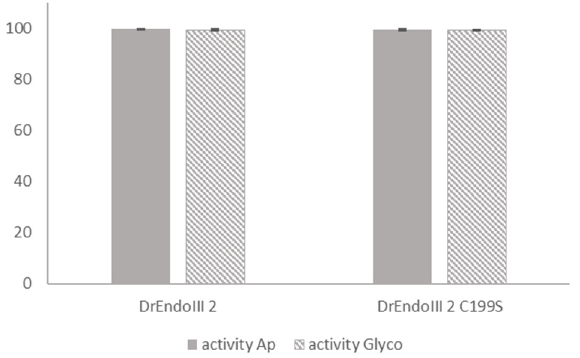
Figure 6. Comparative activity analysis between DrEndoIII2 and its mutant (DrEndoIII2 C199S). Processing of thymine glycol (Tg), in percentage, (plain bars) and Ab-site (striped bars) by DrEndoIII2 and DrEndoIII2 C199S. Histograms represent means and standard deviations of at least three independent experiments.